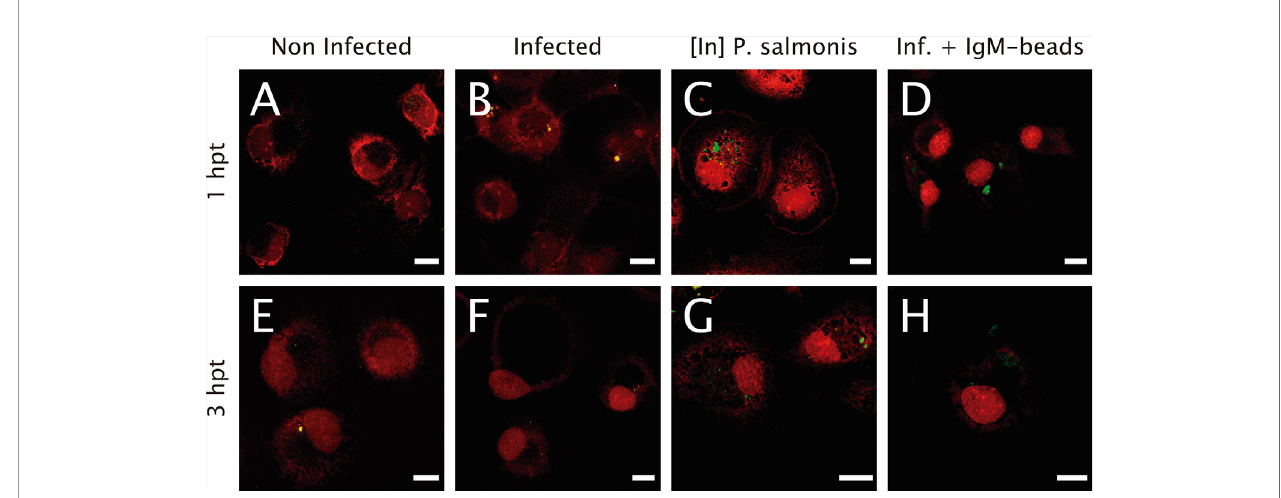
FIGURE 3 | Lysosomal functionality in infected macrophage-enriched cell cultures treated with IgM beads. Macrophage-enriched cell cultures were infected with P. salmonis at a MOI 10 of bacteria/cell, treated with IgM beads and analyzed at 1 and 3 hpt. Cells were treated with the DQ BSA TM Green probe to stain the proteolytic focusses; the nucleus was stained with PI (red). (A, E) Non-infected macrophages analyzed at 1 and 3 hpt. Macrophage-enriched cell cultures incubated with P. salmonis for 1 hpt (B) and 3 hpt (F) . Macrophage-enriched cell cultures incubated with inactivated (In) P. salmonis for 1 hpt (C) and 3 hpt (G) . Macrophage enriched cell cultures infected with P. salmonis and treated with IgM-beads for 1 hpt (D) and 3 hpt (H) . Scale bar: 10 m